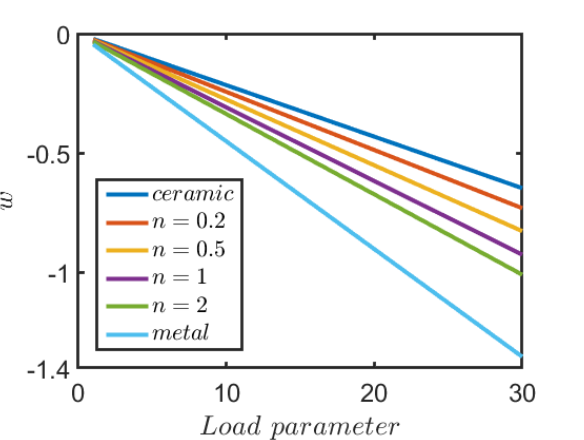
Figure 2. Displacement ¯ w of middle point of a FG square plate composed of Al/ZrO 2 for different values of n p .